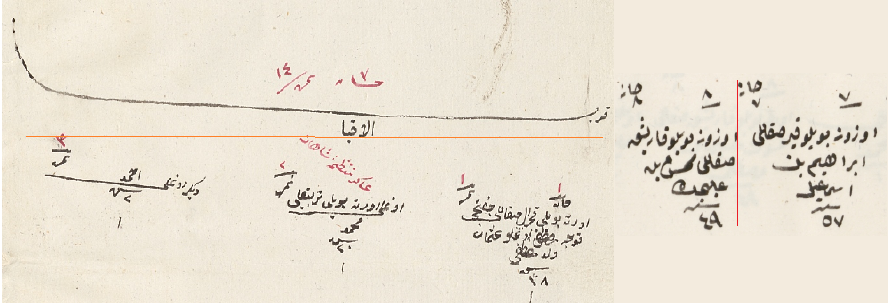
Figure 7. Examples of intertwined rows and columns are shown. They are counted as one since there are not any empty pixels in between. Table 1. Results with different metrics are presented for five different models. ICE, Individual Counting Error. Tested